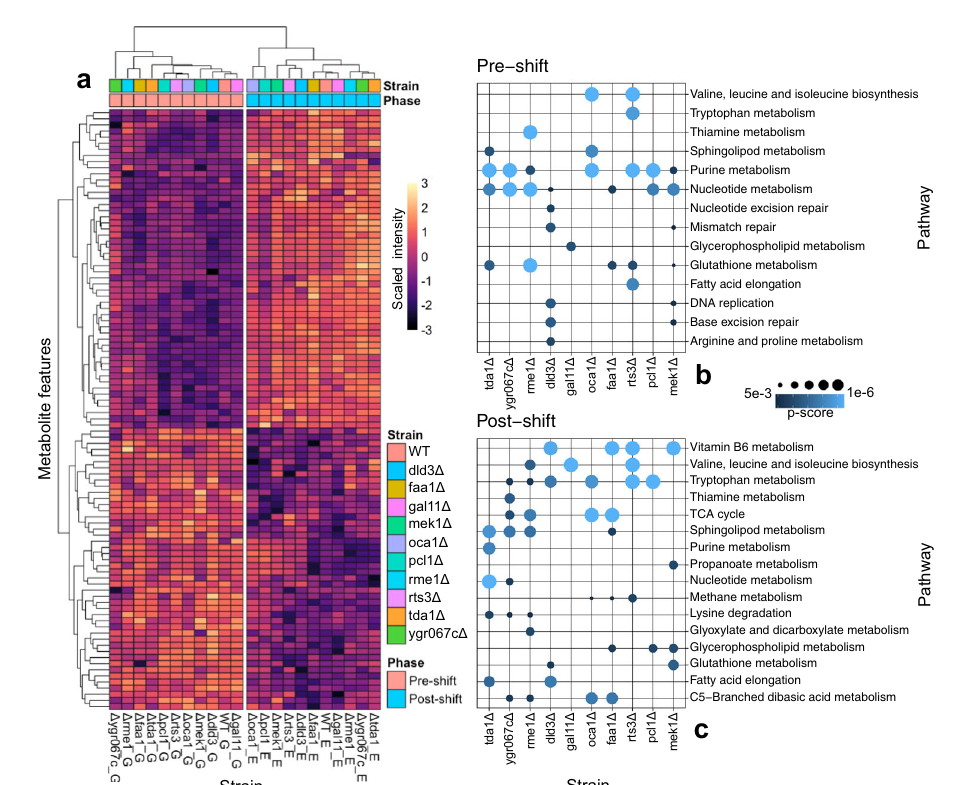
Fig. 1 Metabolic pro fi les of regulatory deletants. a Heatmap based on normalized peak intensities for all the strains involved in the study. Selection of presented metabolites were done by selecting for features most responsible for phase-variation using discriminatory analaysis (oPLS-DA) that were deemed signi fi cant by the linear model (p-value < 0.05). Hierarchical clustering of strains was done via Pearson correlation and Euclidean distance for the metabolites. b Strain-wise pathway enrichment when compared to WT using FELLA (pre-shift, FELLA p-score < 0.01). c Strain-wise pathway enrichment when compared to WT using FELLA (post-shift, FELLA p-score <